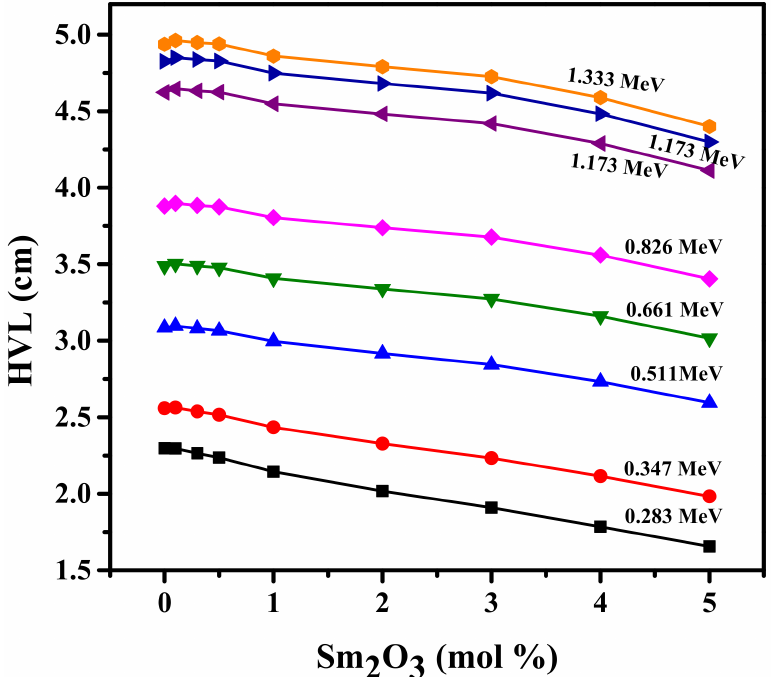
Figure 10. The relation between the half value layer and the Sm 2 O 3 content in the Sm x CNLB